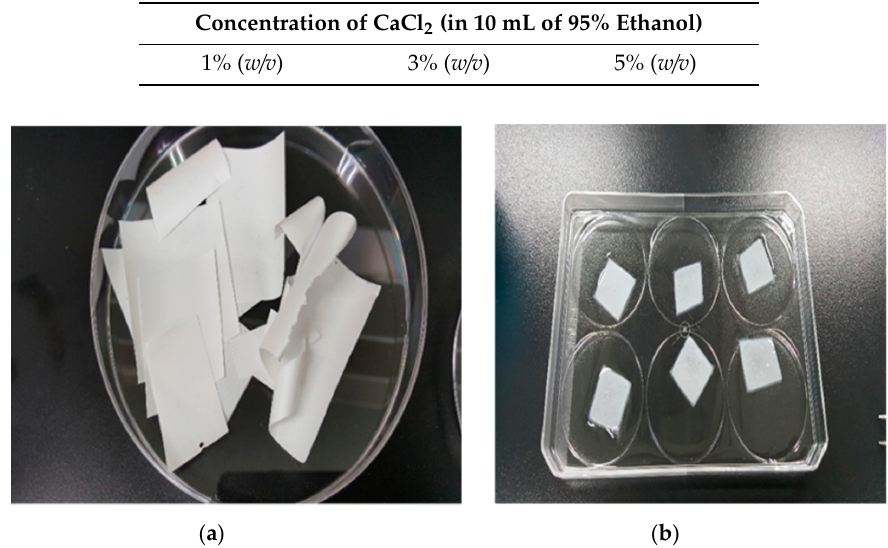
Table 2. Various concentrations of crosslinking agent used in this study.